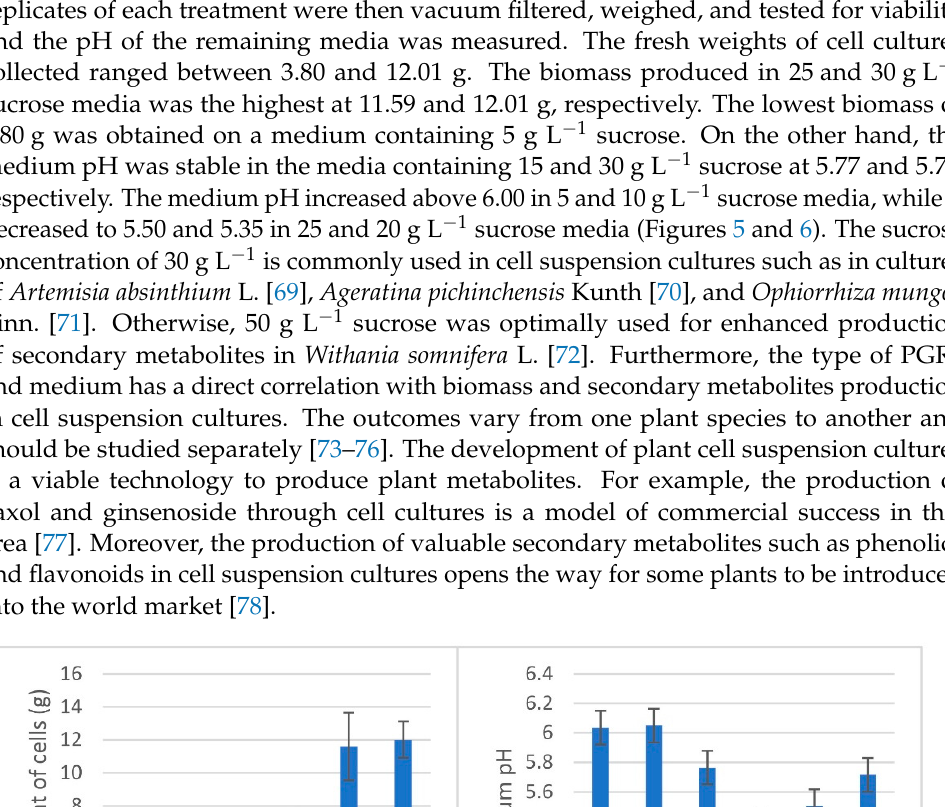
Figure 6. Cell suspension culture of L. schweinfurthii on N2 medium with 30 g L − 1 sucrose after 9 days of culture .